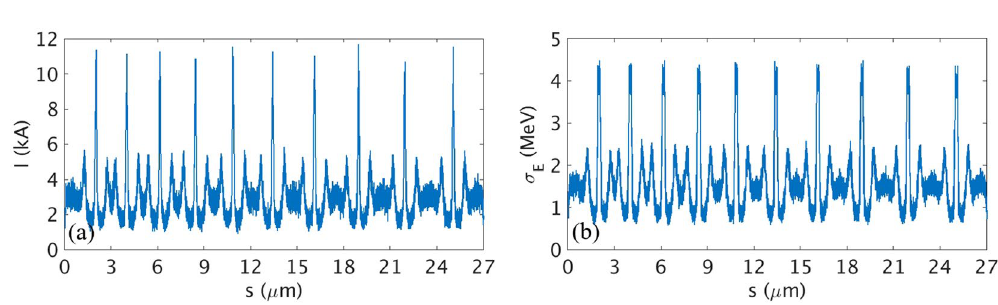
Figure 6. ( a ) Current profile and ( b ) SES profile of the electron beam for the case of multi current spikes with 10 kA peak